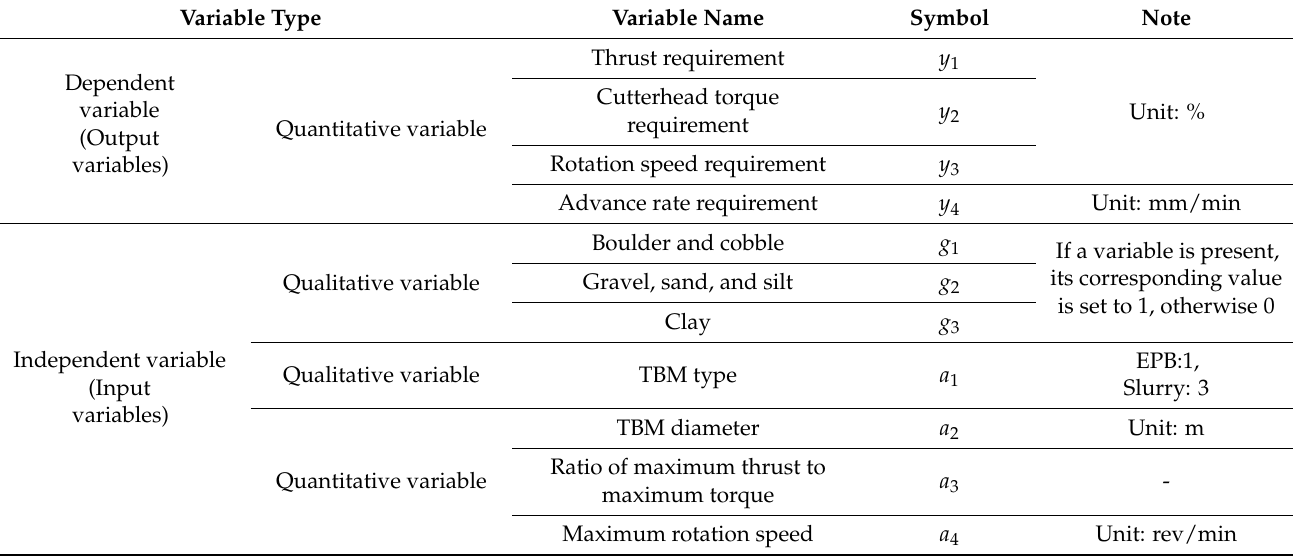
Table 1. Dependent and independent variables used for multiple regression to estimate four operating